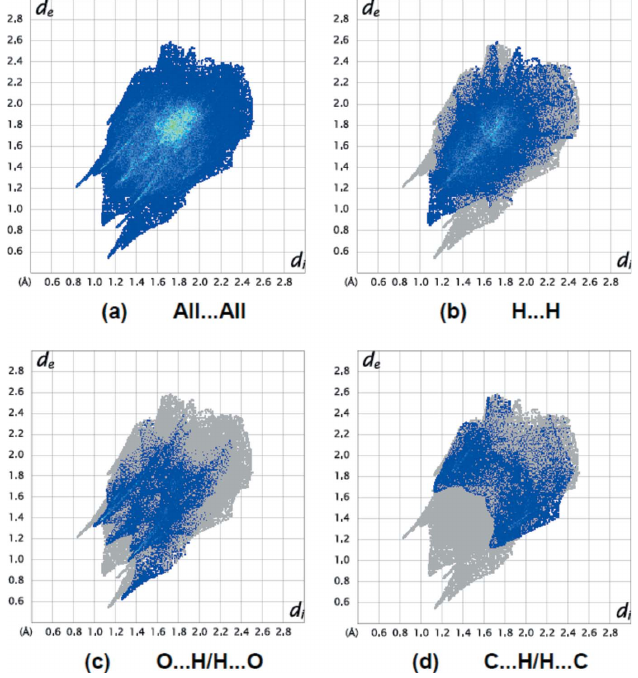
Figure 6 Two-dimensional fingerprint plots for the title compound, showing ( a ) all interactions, and delineated into ( b ) H (cid:2)(cid:2)(cid:2) H, ( c ) O (cid:2)(cid:2)(cid:2) H/H (cid:2)(cid:2)(cid:2) O and ( d ) C (cid:2)(cid:2)(cid:2) H/H (cid:2)(cid:2)(cid:2) C interactions. The d i and d e values are the closest internal and external distances (in A˚ ) from given points on the Hirshfeld surface.